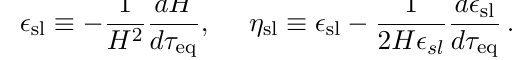
Figure 4 . Sample solution on the large volume branch with p = q = 4 , Λ D = 1 , H 0 /M 4 = 0 . 0078 and an initial ‘ = 0 perturbation. Left: the effective Hubble rate, H/M with the same value of n on the small volume branch. The slow roll parameters (cid:15) η sl (right) during the transition. All plots are shown as a function of proper time (in particular as measured at θ = π/ 2 , though here the solutions remain